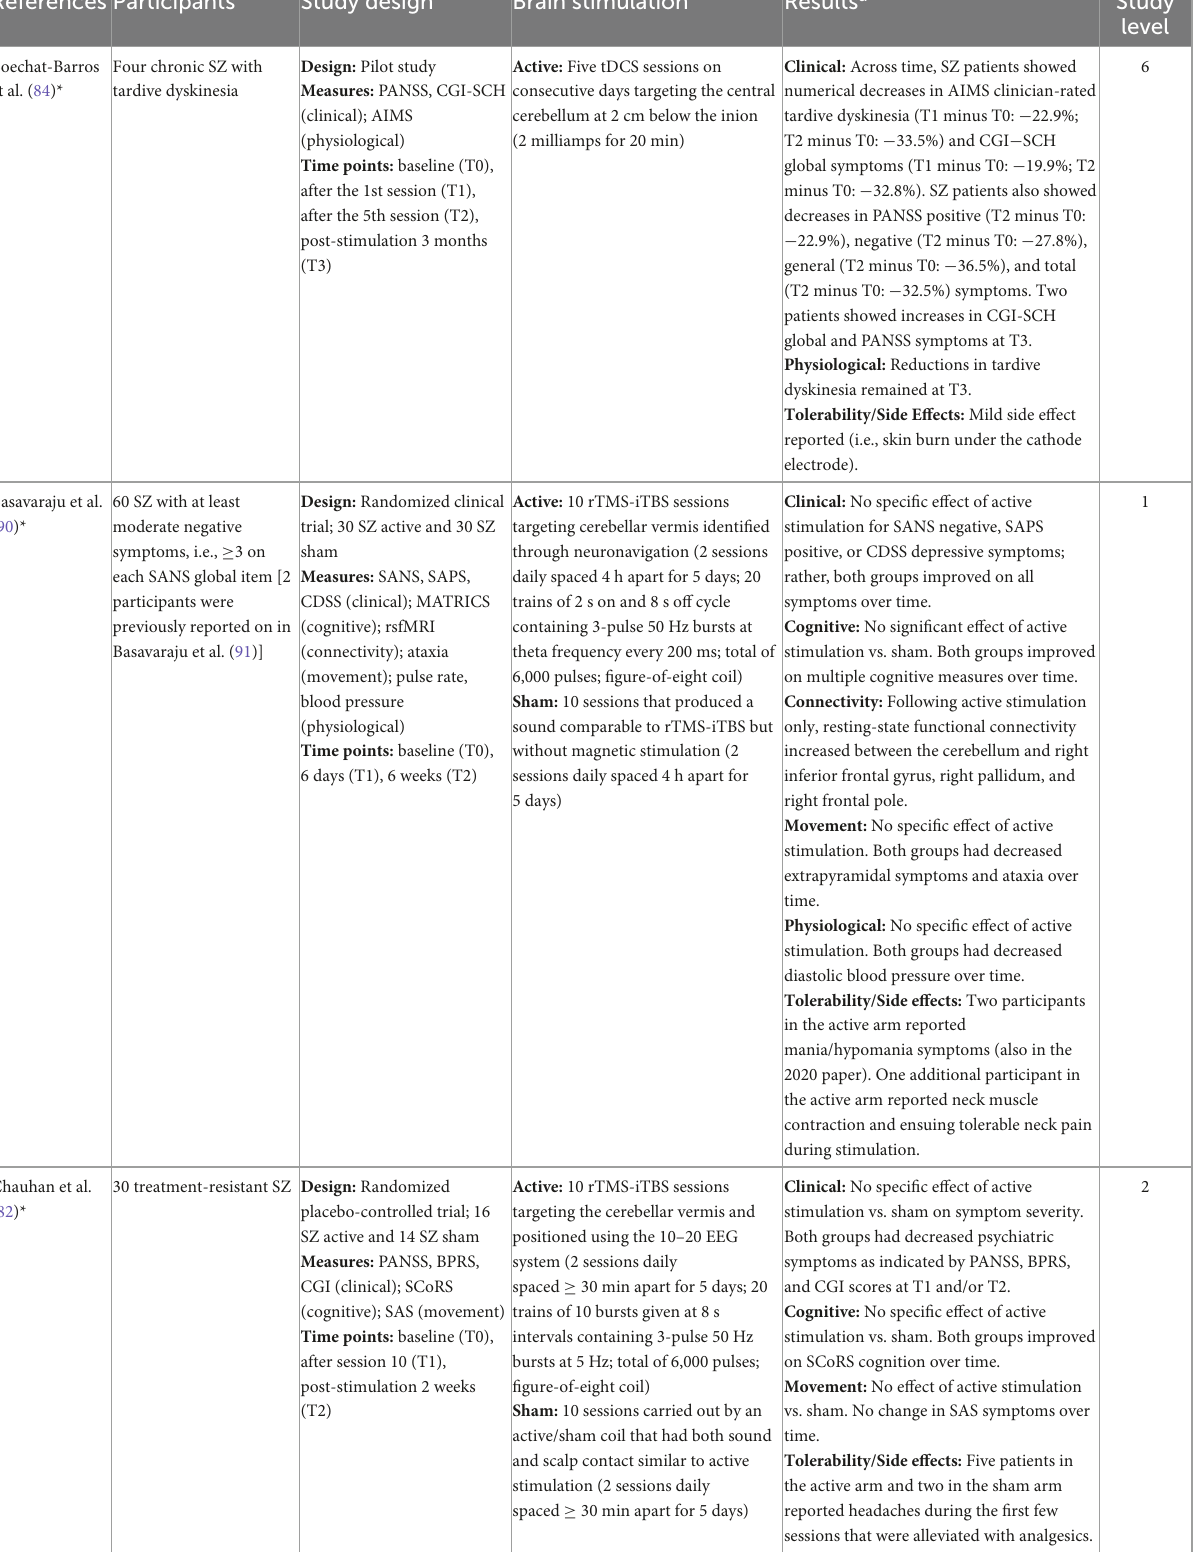
TABLE 1 Characteristics of clinical studies reporting on cerebellar stimulation in